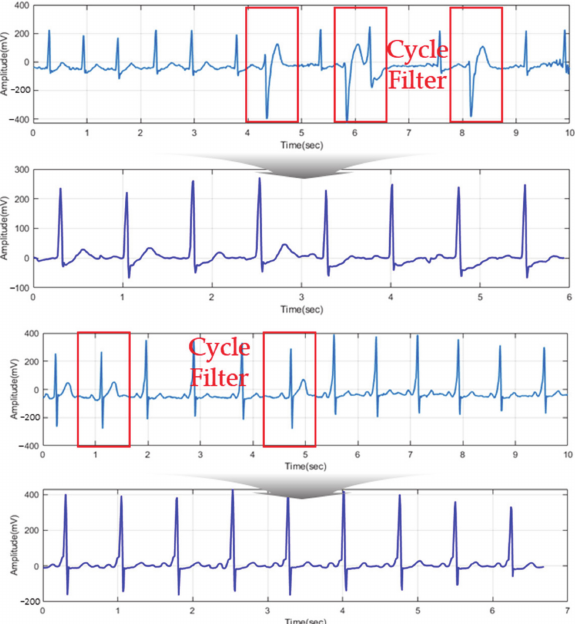
Figure 9. ECG signal normalized by adaptive filter for each